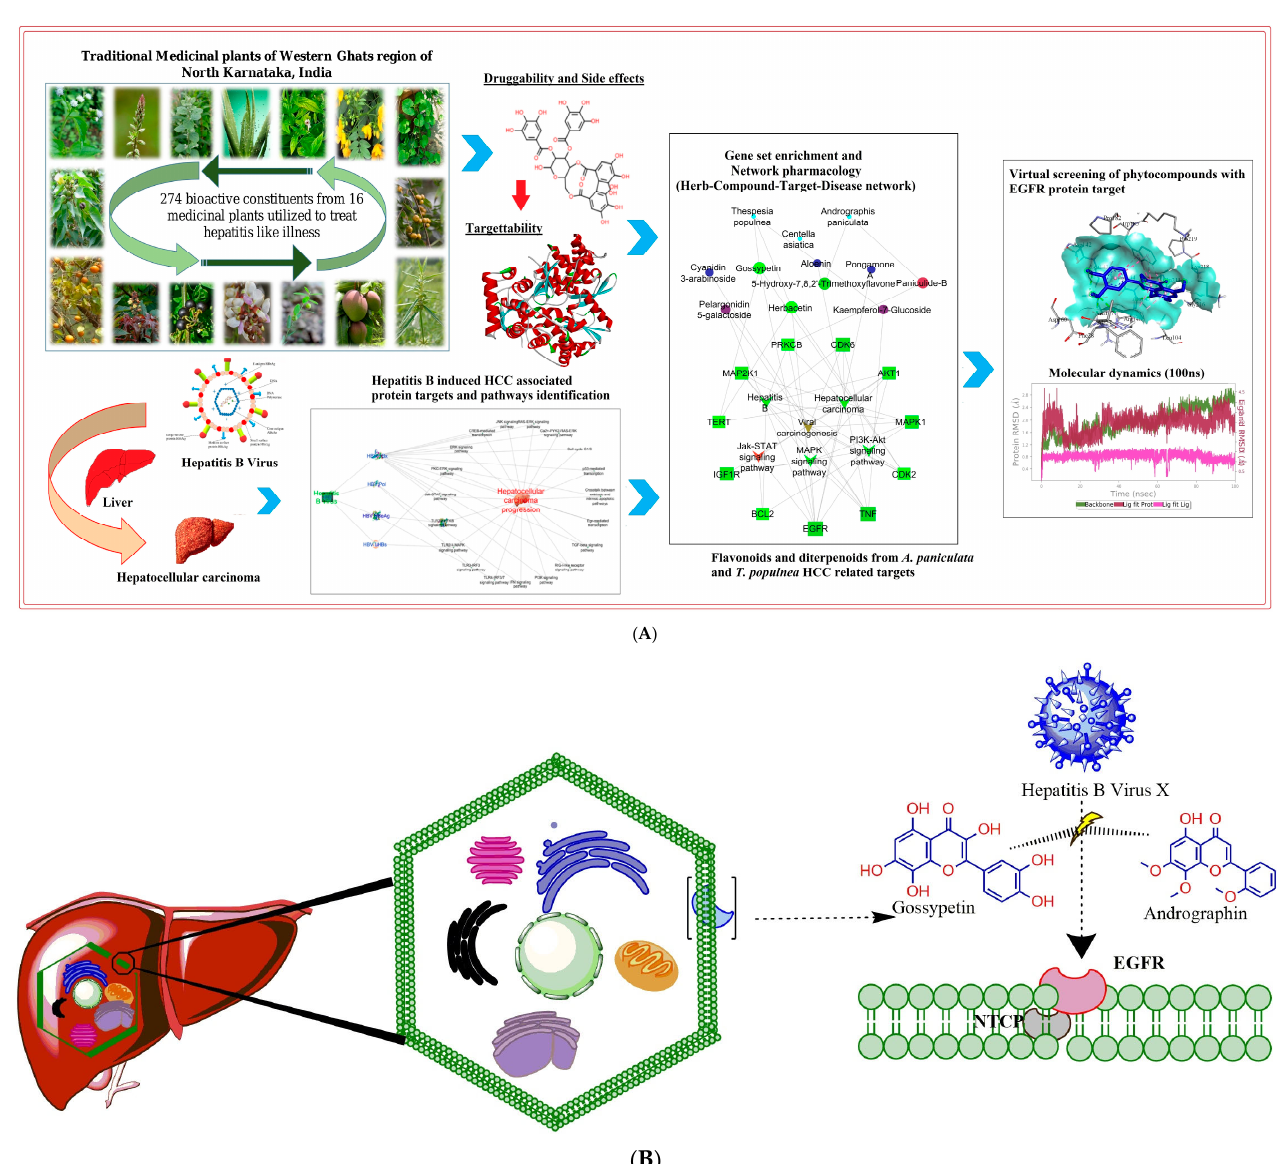
Figure 1. ( A ). Workflow implemented in the present study. ( B ). Results highlight of the present study.